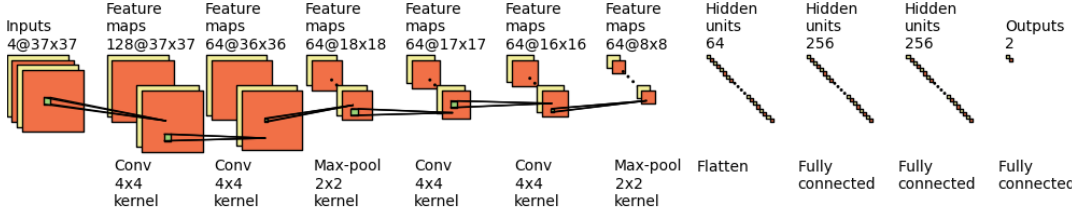
Figure 1 . Architecture of our CNN top